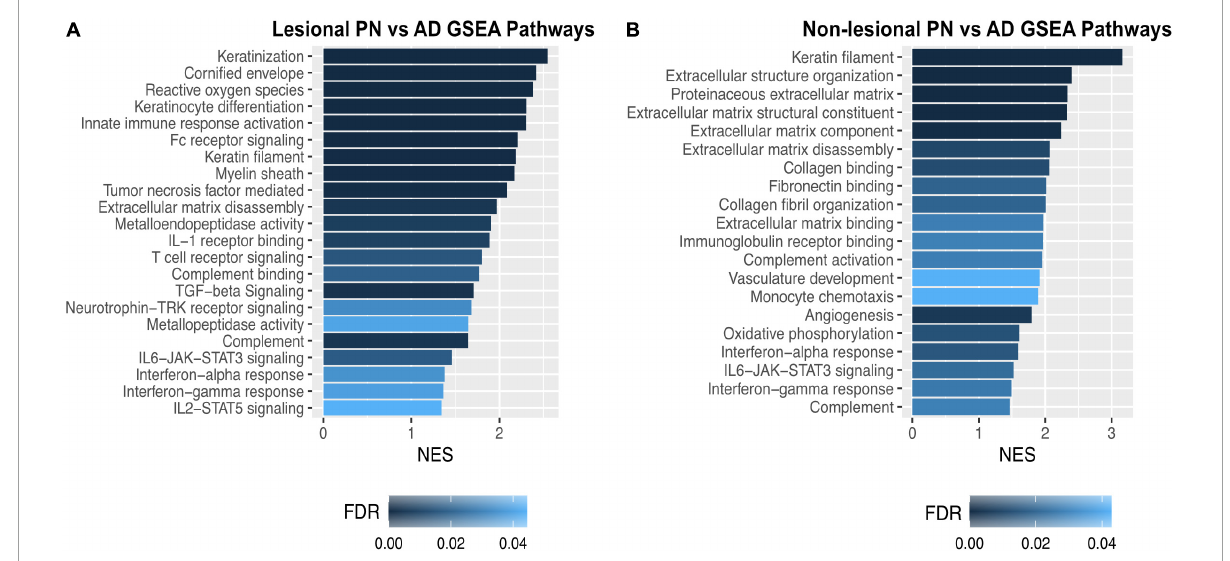
FIGURE3 Gene set enrichment analysis of dysregulated genetic pathways in prurigo nodularis (PN) and atopic dermatitis (AD) skin. (A) Gene set enrichment analysis (GSEA) for selected significant immune pathways in PN lesional vs. AD lesional skin. (B) GSEA for selected significant immune pathways in PN non-lesional vs. AD non-lesional skin. FC, fold change; FDR, false discovery rate p -values; NES, normalized enrichment score.